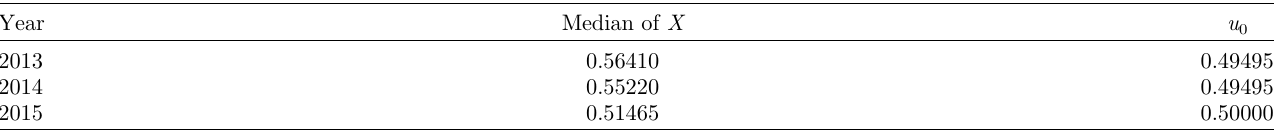
Table 5. Median values of X and its corresponding u 0